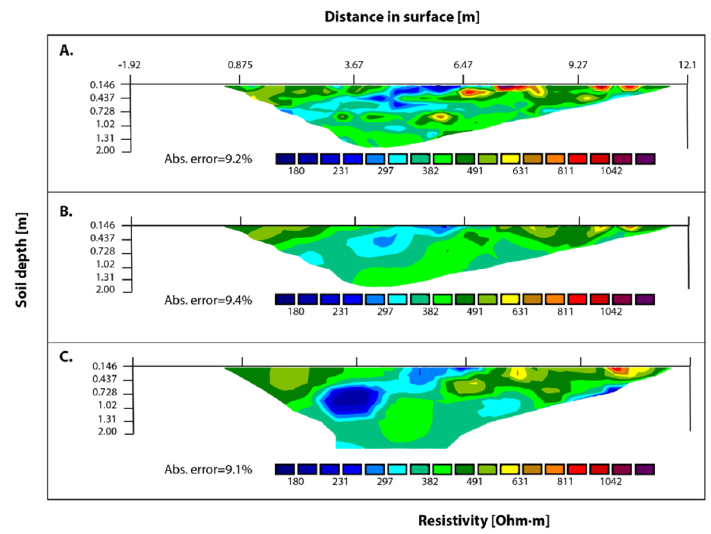
Figure 4. Inverse model resistivity section tomography plots of three farms in three municipalities of Arauca. ( A ) Arauquita (840 Ohm · m); ( B ) Saravena (872 Ohm · m); and ( C ) Tame (855 Ohm · m). Arauca. ( A ) Arauquita (840 Ohm·m); ( B ) Saravena (872 Ohm·m); and ( C ) Tame (855 Ohm·m).